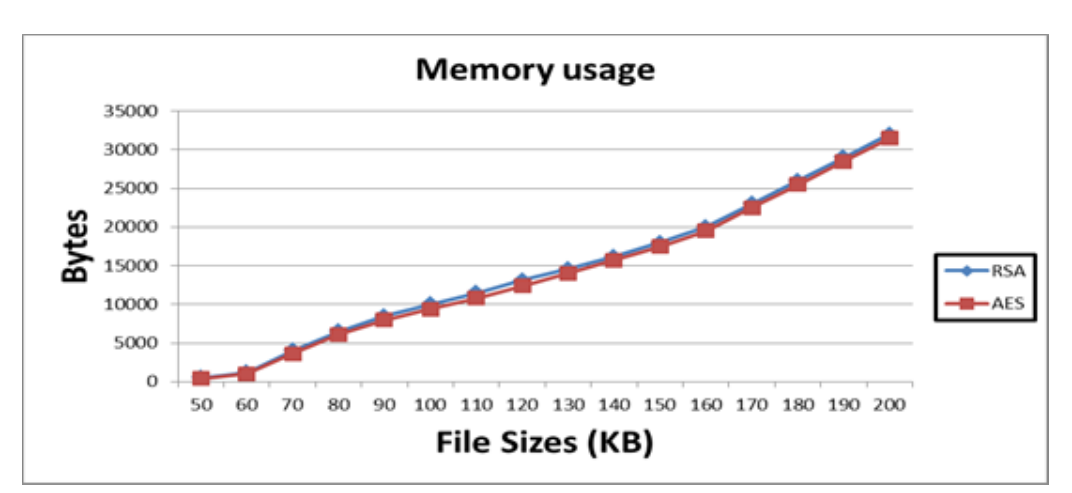
Figure 11 . Memory Usage